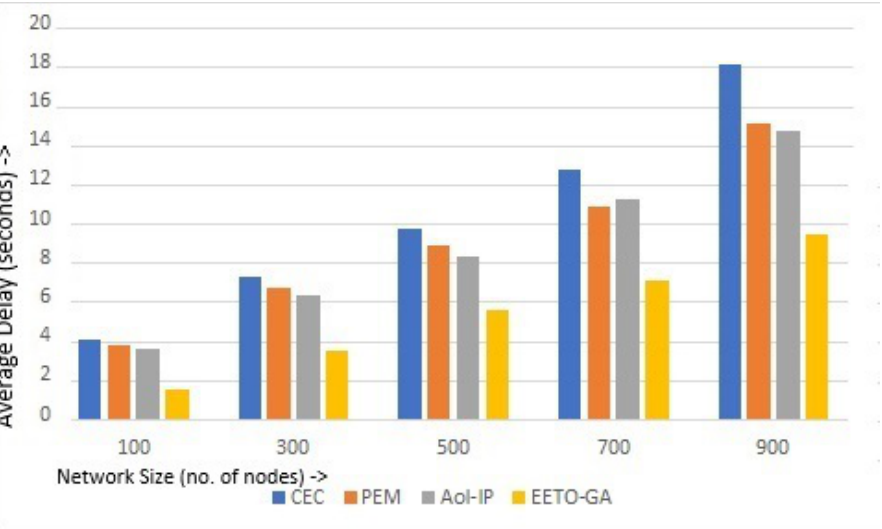
Figure 6. Average delay in execution of task (ADET) in proposed EETO-GA and other